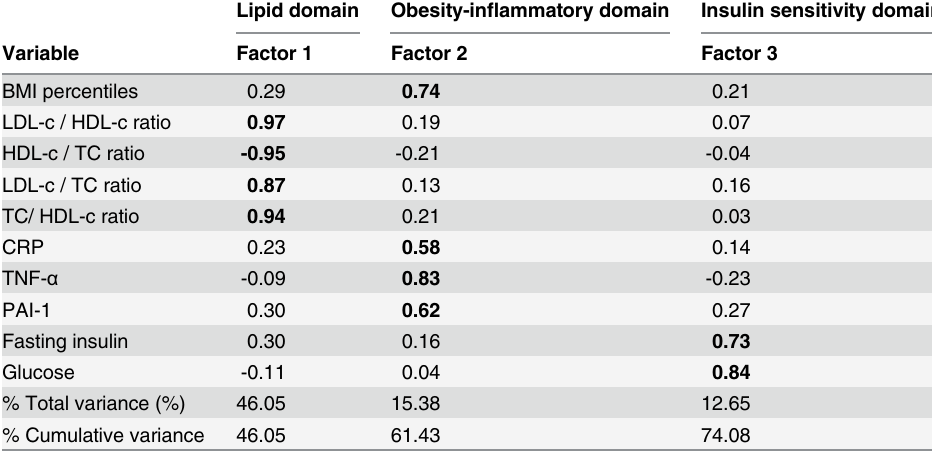
Table 4. The results of a principal component factor analysis with a Varimax rotation among obese male